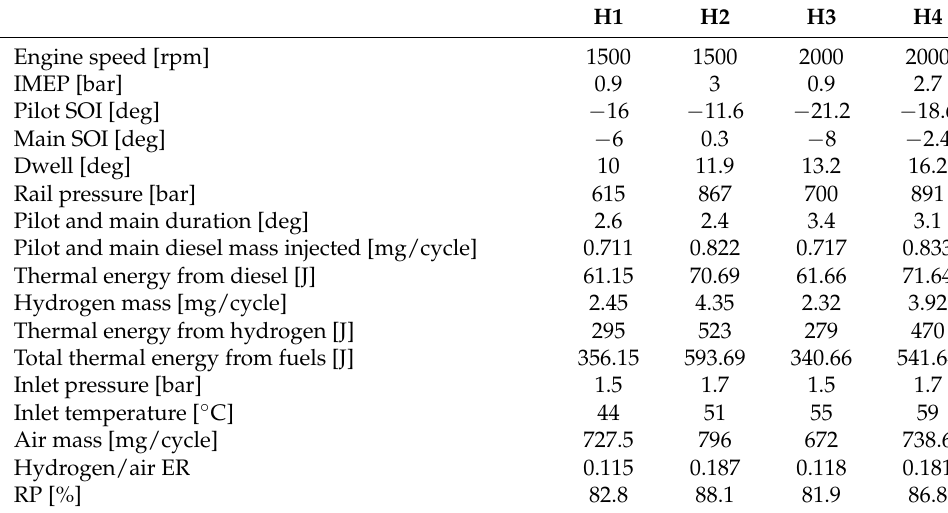
Table 5. Engine operating conditions for the test cases with